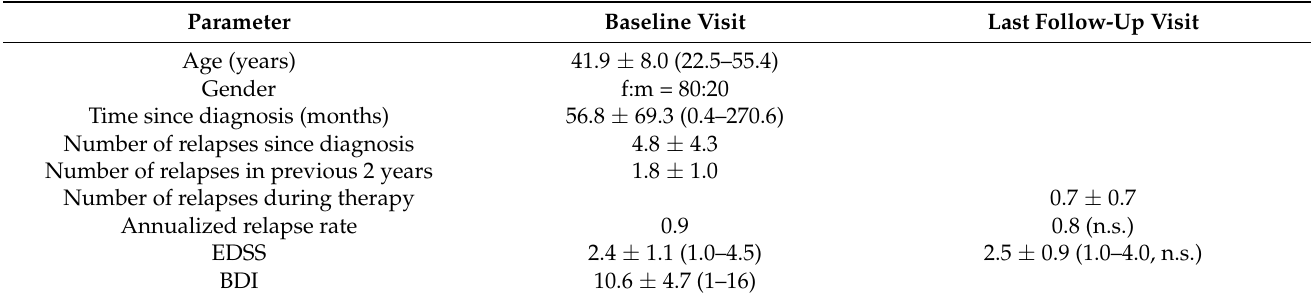
Table 1. Baseline and follow-up characteristics ( n =